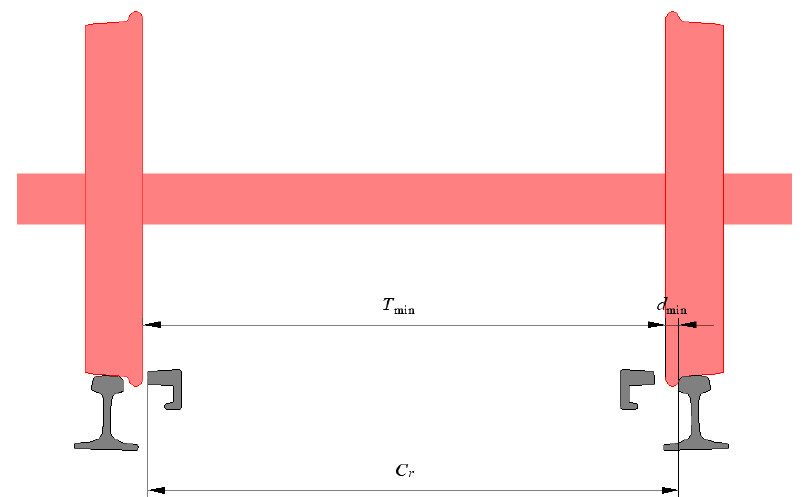
Figure 3. Calculation method for the guardrail interval limit.